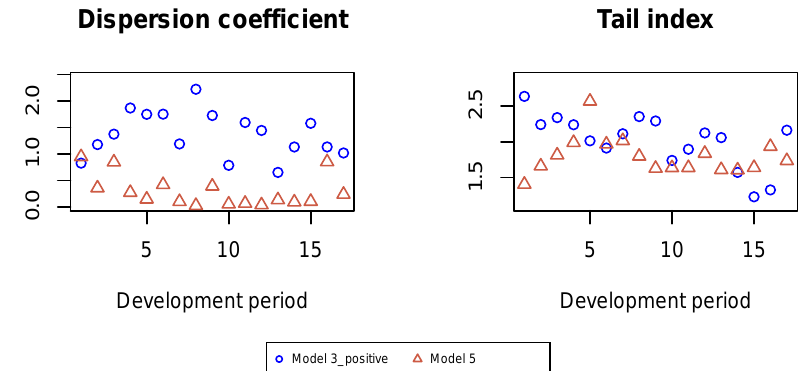
Figure A18. Estimates of tail indices and constant dispersion coefficients in Models 3_positive and 5.